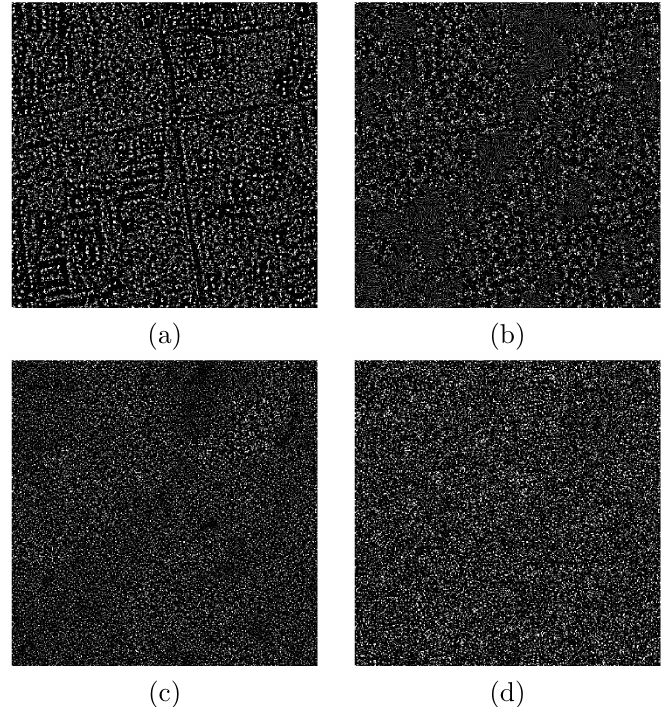
Figure 20. Chicago test case. Zoom of ratio images obtained after proceeding with the filtering algorithms: ( a ) Kuan, ( b ) PPB-it, ( c ) FANS, and ( d )